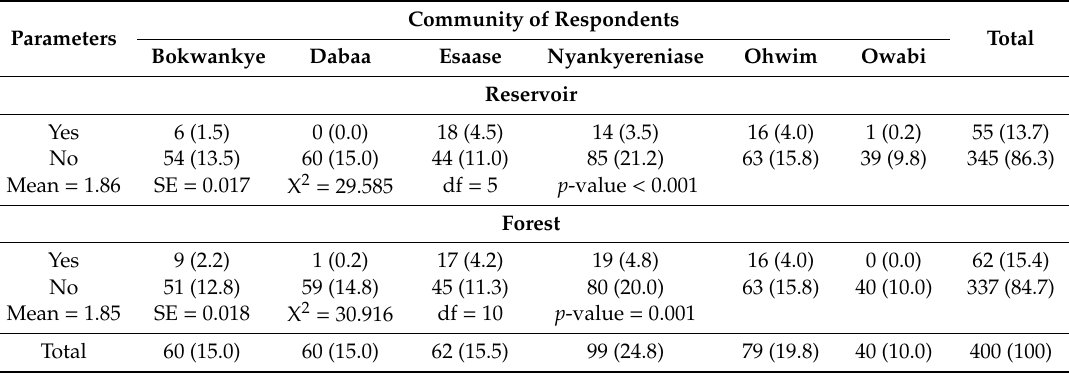
Table 8. Communities’ participation in the management of the Owabi